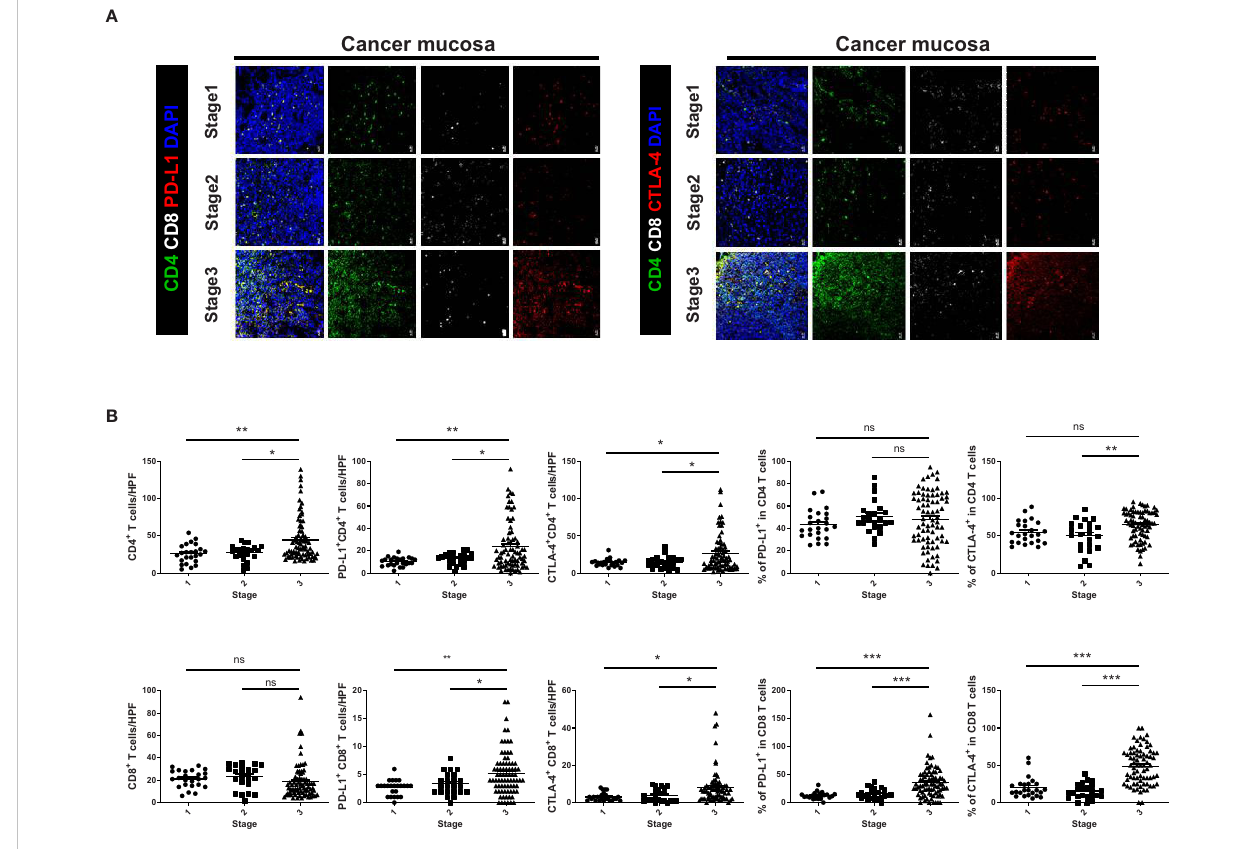
FIGURE 2 Expression levels of immunosuppressive markers on CD4 + and CD8 + T cells were increased in cancer tissue from GC patients with increasing TNM stage. (A) Confocal microscopic analysis of cancer mucosa from GC patients. Representative confocal images showing PD-L1 + CD4 + , CTLA-4 + CD4 + , PD-L1 + CD8 + , and CTLA-4 + CD8 + T cells in cancer tissues. (B) Bar graphs show mean number of cells per HPF in cancer tissues according to cancer stage (Stages I – III, n = 24, = 23, and = 83, respectively). Scale bar = 20 m m. Data are means ± standard errors of the mean (* p < 0.05, ** p < 0.01, *** p <